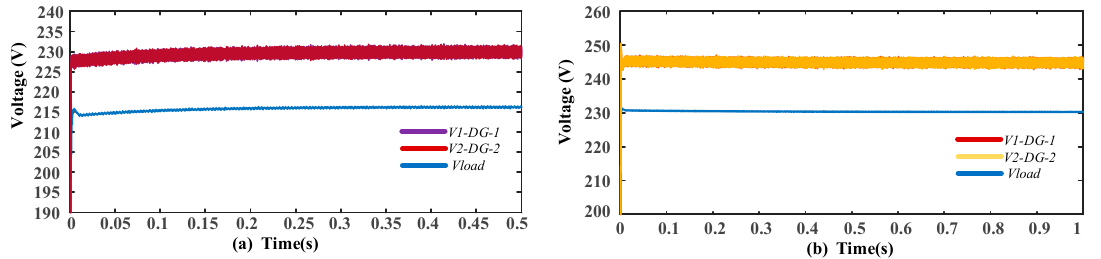
Figure 12. ( a ) Inverter terminal and load voltages for the conventional control strategy; ( b ) inverter terminal and load voltages for the proposed control strategy.